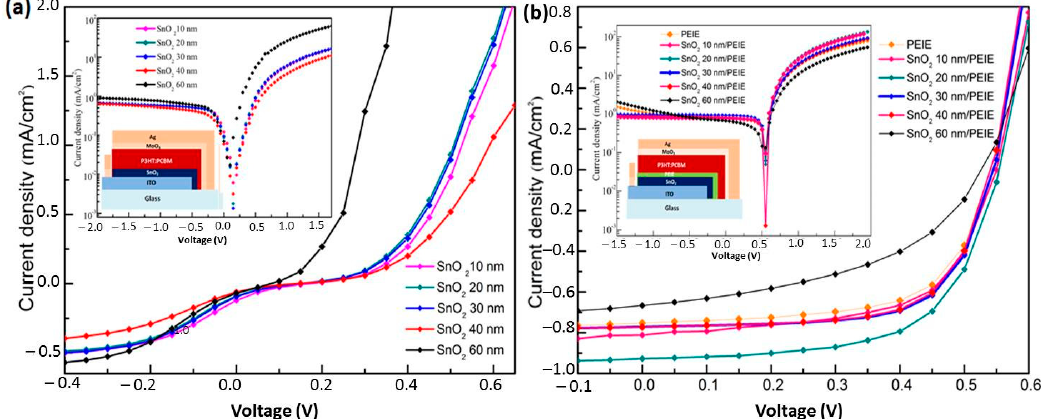
Figure 6. J–V characteristics of glass/ITO/SnO 2 /P3HT:PCBM/MoO 3 /Ag ( a ) and glass/ITO/SnO 2 /PEIE/P3HT:PCBM/MoO 3 /Ag; ( b ) devices with different thicknesses of SnO 2 (10, 20, 30, 40, 60 nm).